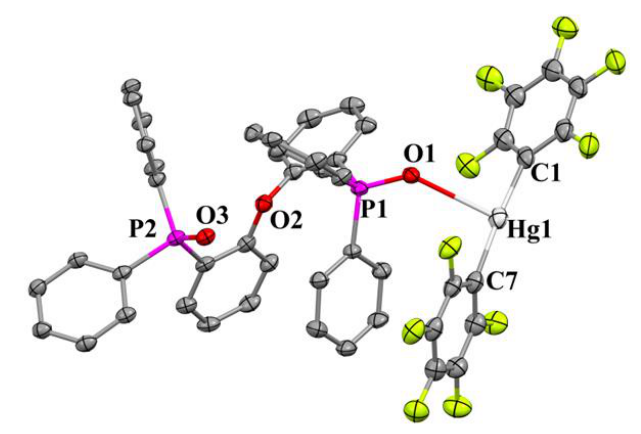
Figure 4. Molecular structure of 3Hg . All hydrogen atoms are omitted for clarity. Displacement ellipsoids are drawn at the 30% probability level. Selected bond lengths (Å) and bond angles ( ◦ ): Hg1-O1 2.711(3), Hg1-C1 2.070(5), Hg1-C7 2.064(5), P1-O1 1.493(3), P2-O3 1.486(3). C1-Hg1-O1 88.11(15), C7-Hg1-O1 95.62(14), C7-Hg1-C1 175.15(17). Table 4. Hydrogen-bonds geometry (Å , °) of 3Hg .